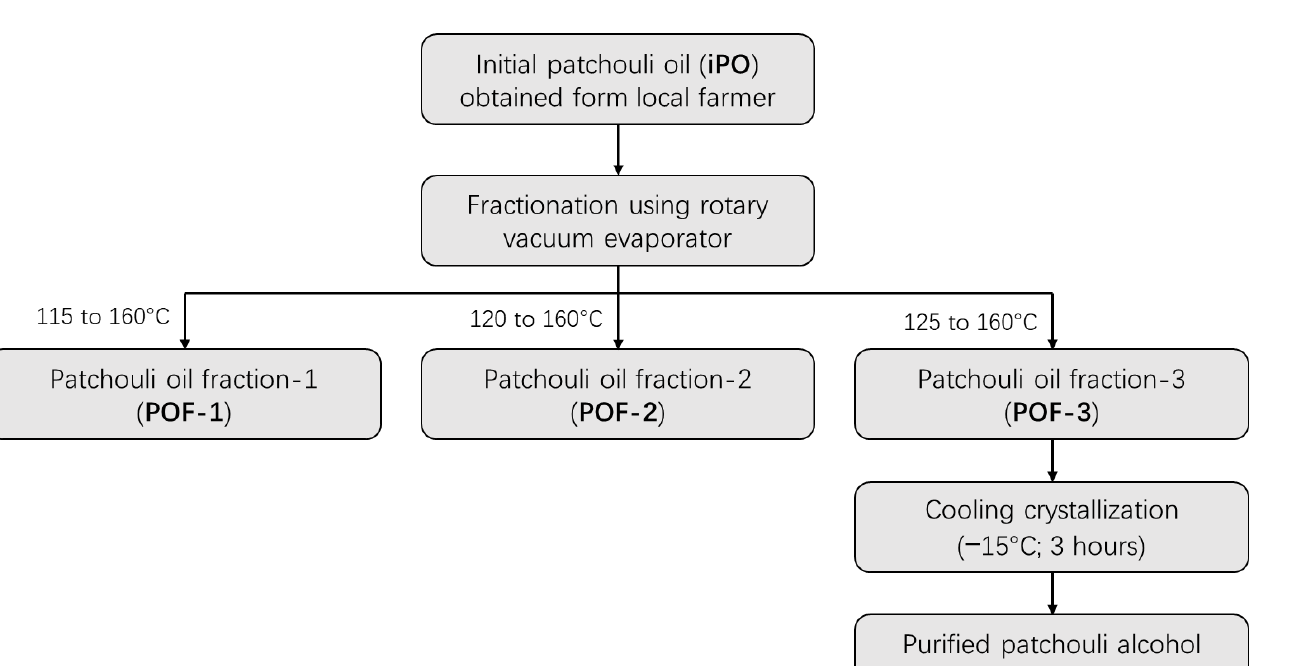
Scheme 1. Fractionation of initial patchouli oil (iPO), and its purification into purified patchouli alcohol (pPA) crystal.